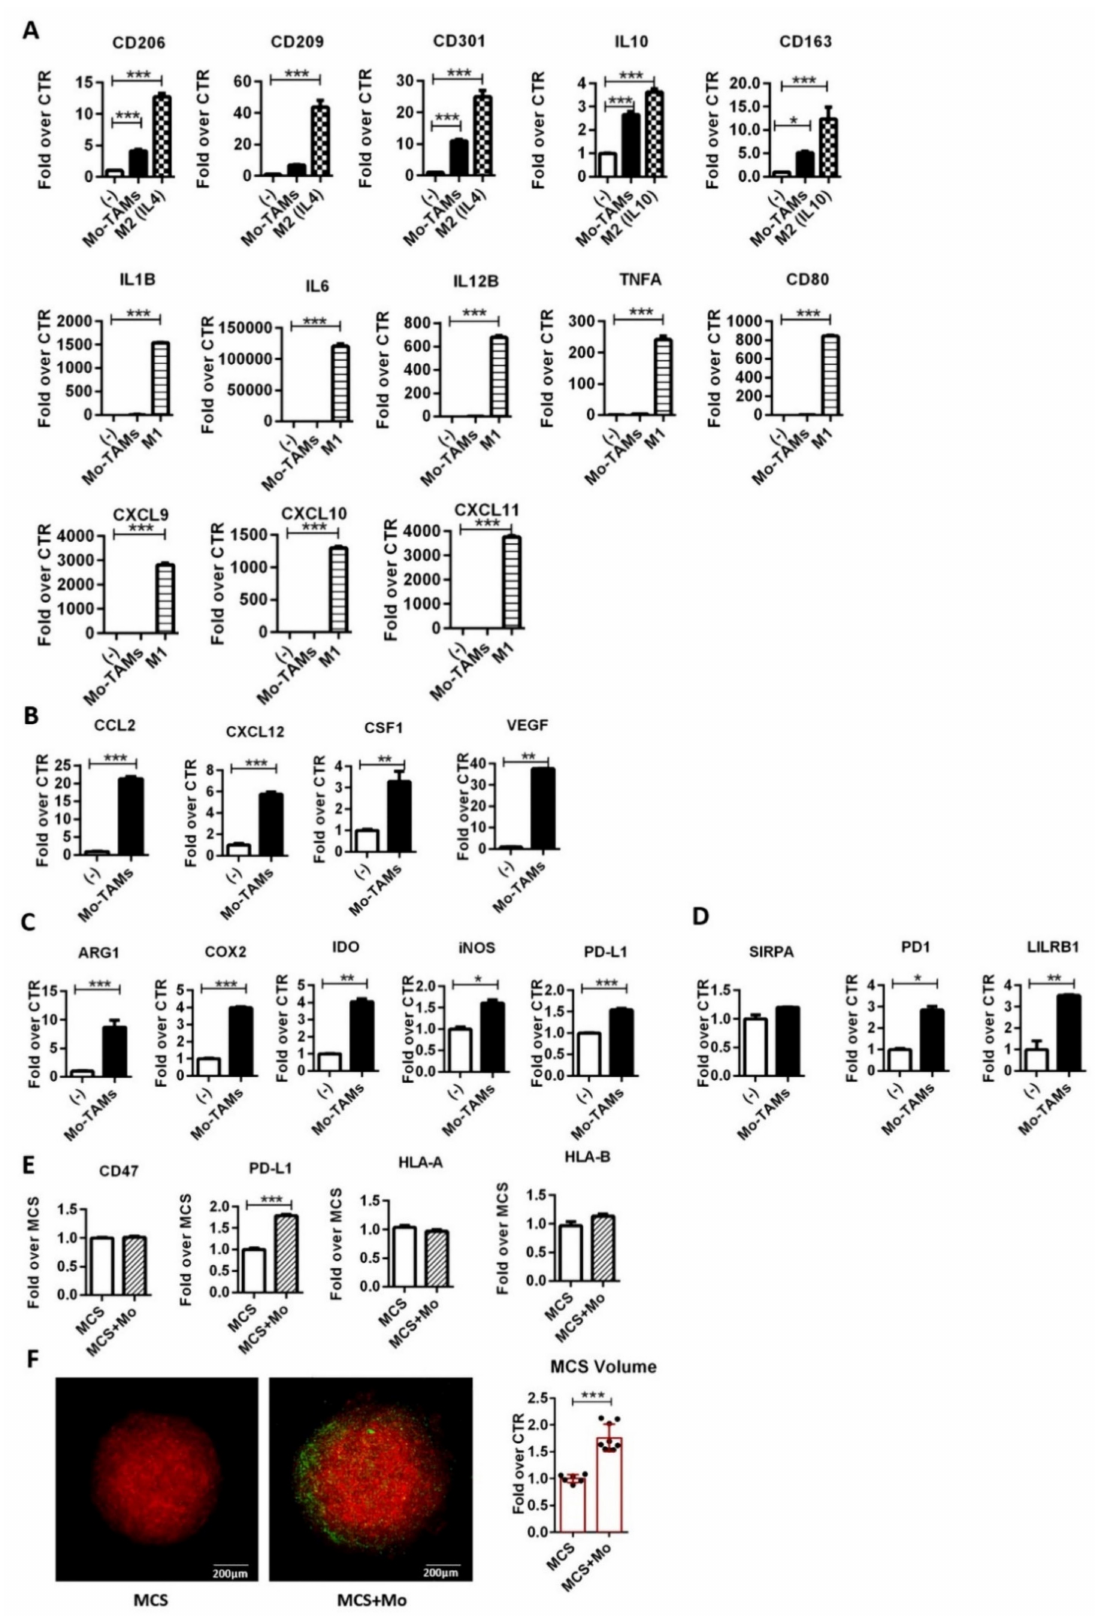
Figure 2. MCS-infiltrating monocytes acquire a functional TAM-like phenotype. ( A – D ) Monocytes-derived TAMs (Mo- TAMs) were isolated from MCS by magnetic cell sorting and analyzed by RT-PCR for the expression of genes encoding for selected ( A ) M1 (IL1, IL6, IL12B, TNFA, CD80, CXCL9, CXCL10, CXCL11), M2(IL4) (CD206, CD209, CD301), and M2(IL10) (IL10 and CD163) markers; ( B ) TAM-recruiting chemokines (CCL2 and CXCL12) and growth factors (CSF1 and